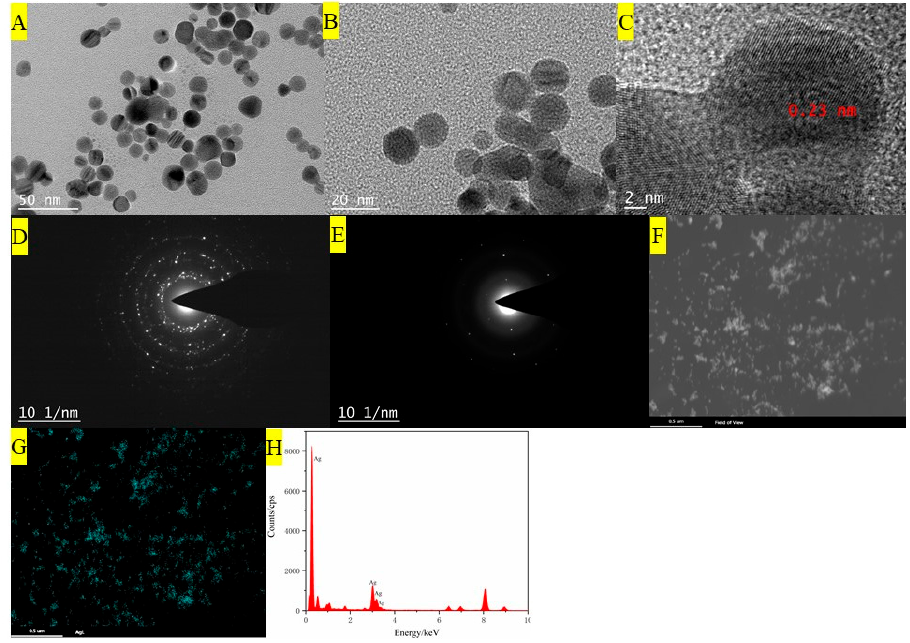
Figure 1. TEM-SAED patterns of AgNPs ( A – E ), STEM-EDS mapping image of AgNPs ( F – H ).